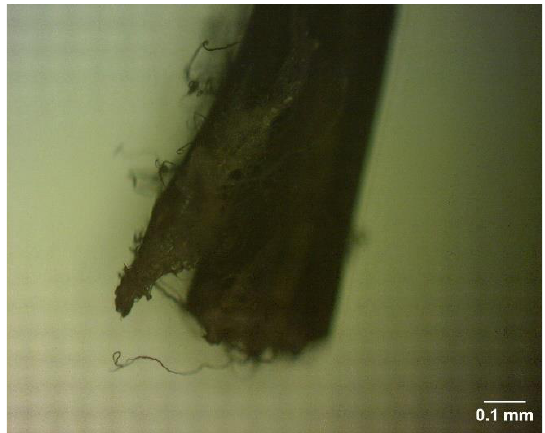
Figure 10. The cross-sectional area of a fiber.